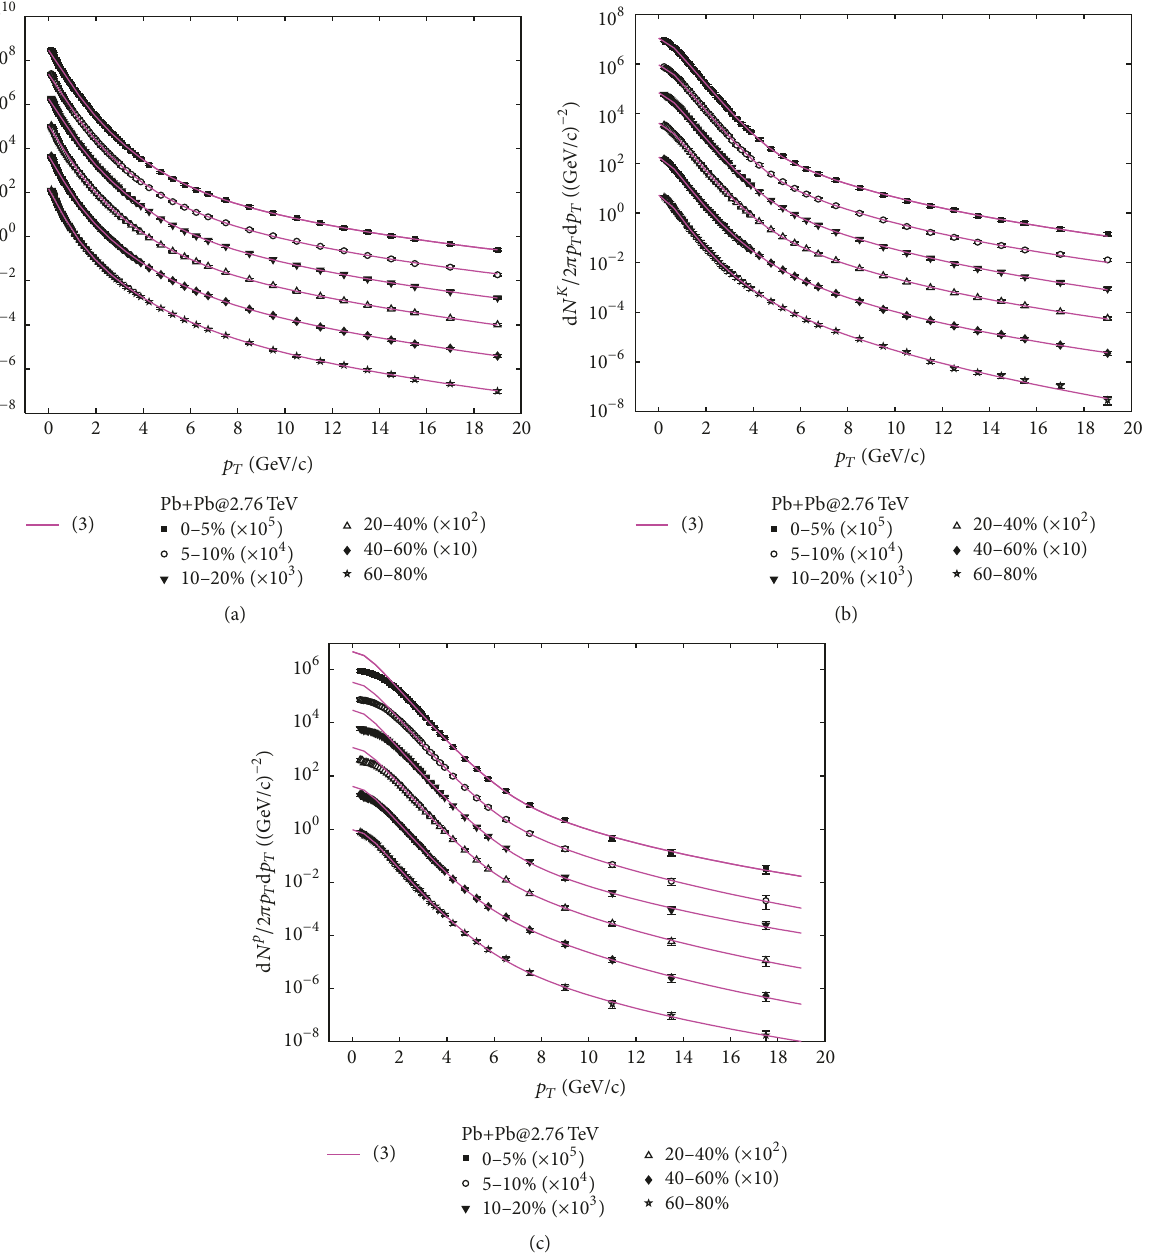
Figure 1: Fitting results using the double-Tsallis distribution (3) for (a) 𝜋 + + 𝜋 − , (b) 𝐾 + + 𝐾 − , and (c) 𝑝 + 𝑝 in Pb+Pb collisions at √𝑠 NN = 2.76 TeV. For a better visualization both the data and the analytical curves have been scaled by a constant as indicated. Data are taken from ALICE